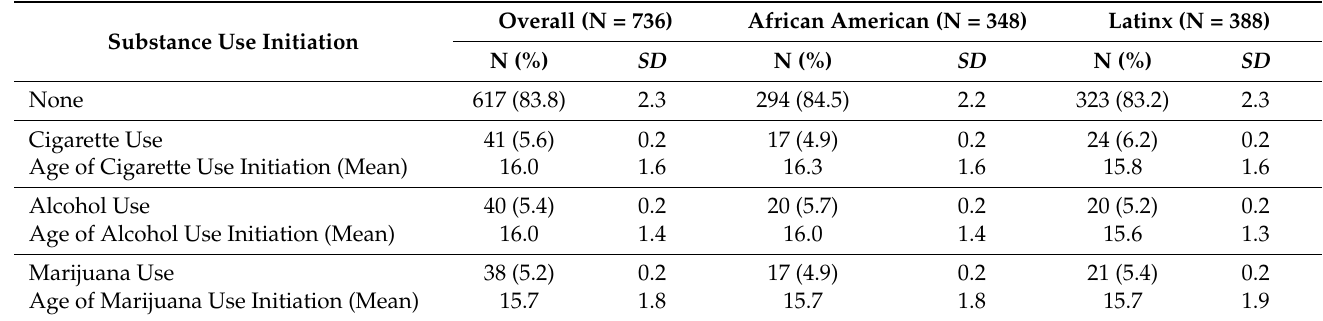
Table 2. Prevalence and average age of substance use